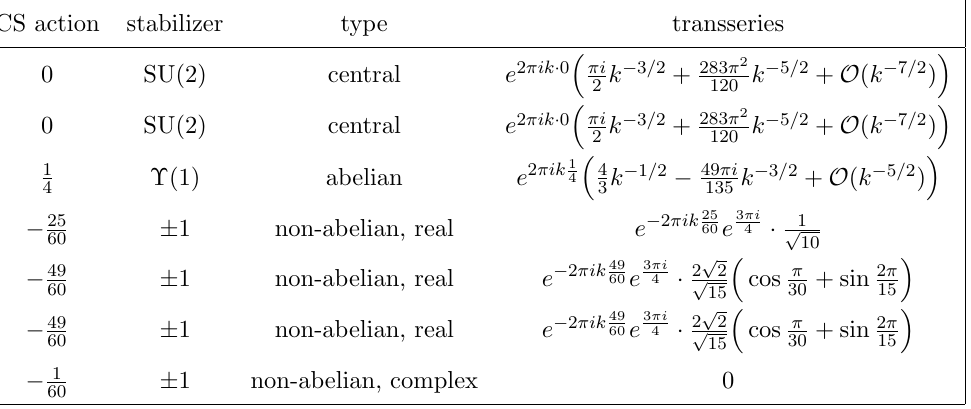
Table 9 . Transseries and classi(cid:12)cation of (cid:13)at connections on M (